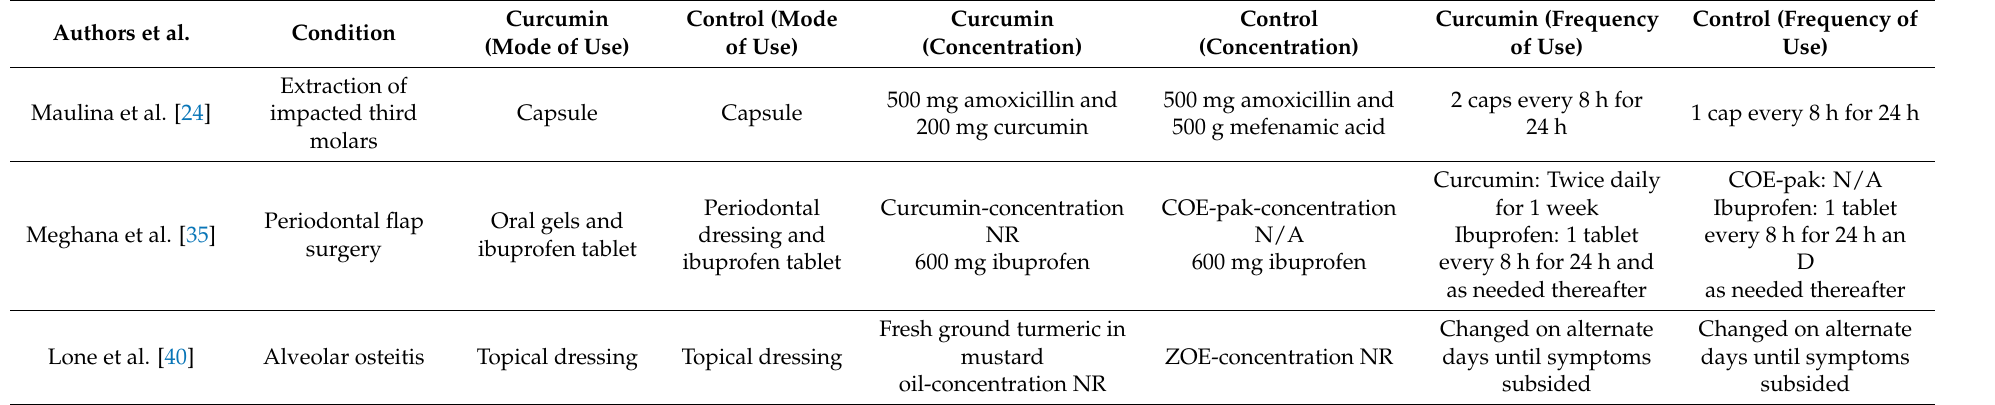
Table 3. Characteristics of studies related to curcumin-combination treatments of study